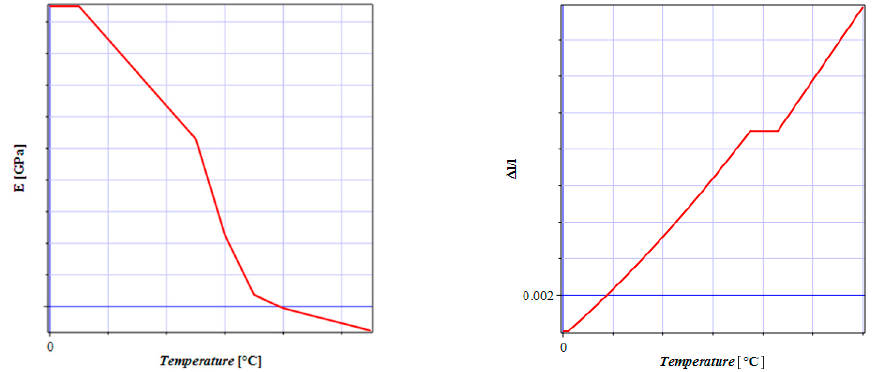
Figure 2. Young modulus (left graph) and relative elongation (right graph) temperature variations.